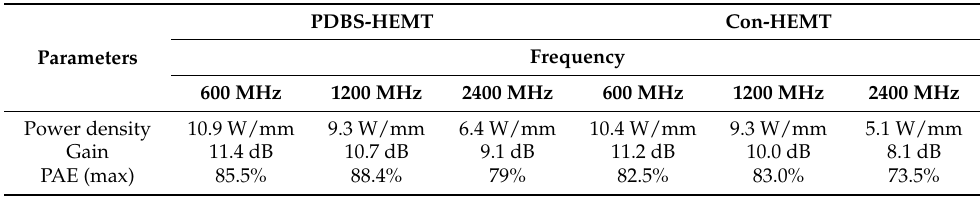
Table 2. Comparison of output characteristics of the PDBS-HEMT and Con-HEMT at differ- ent